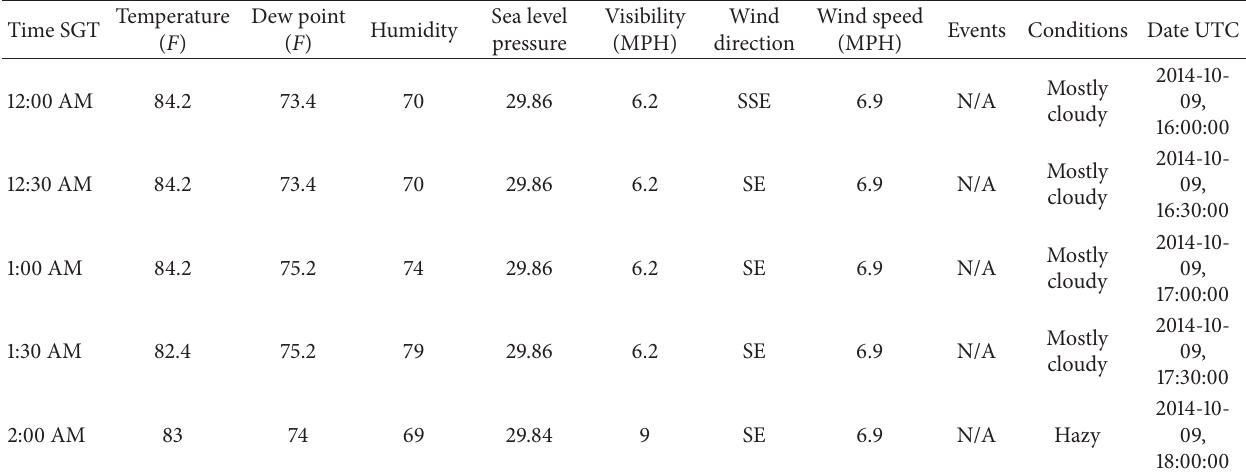
Table 2: A sample of weather